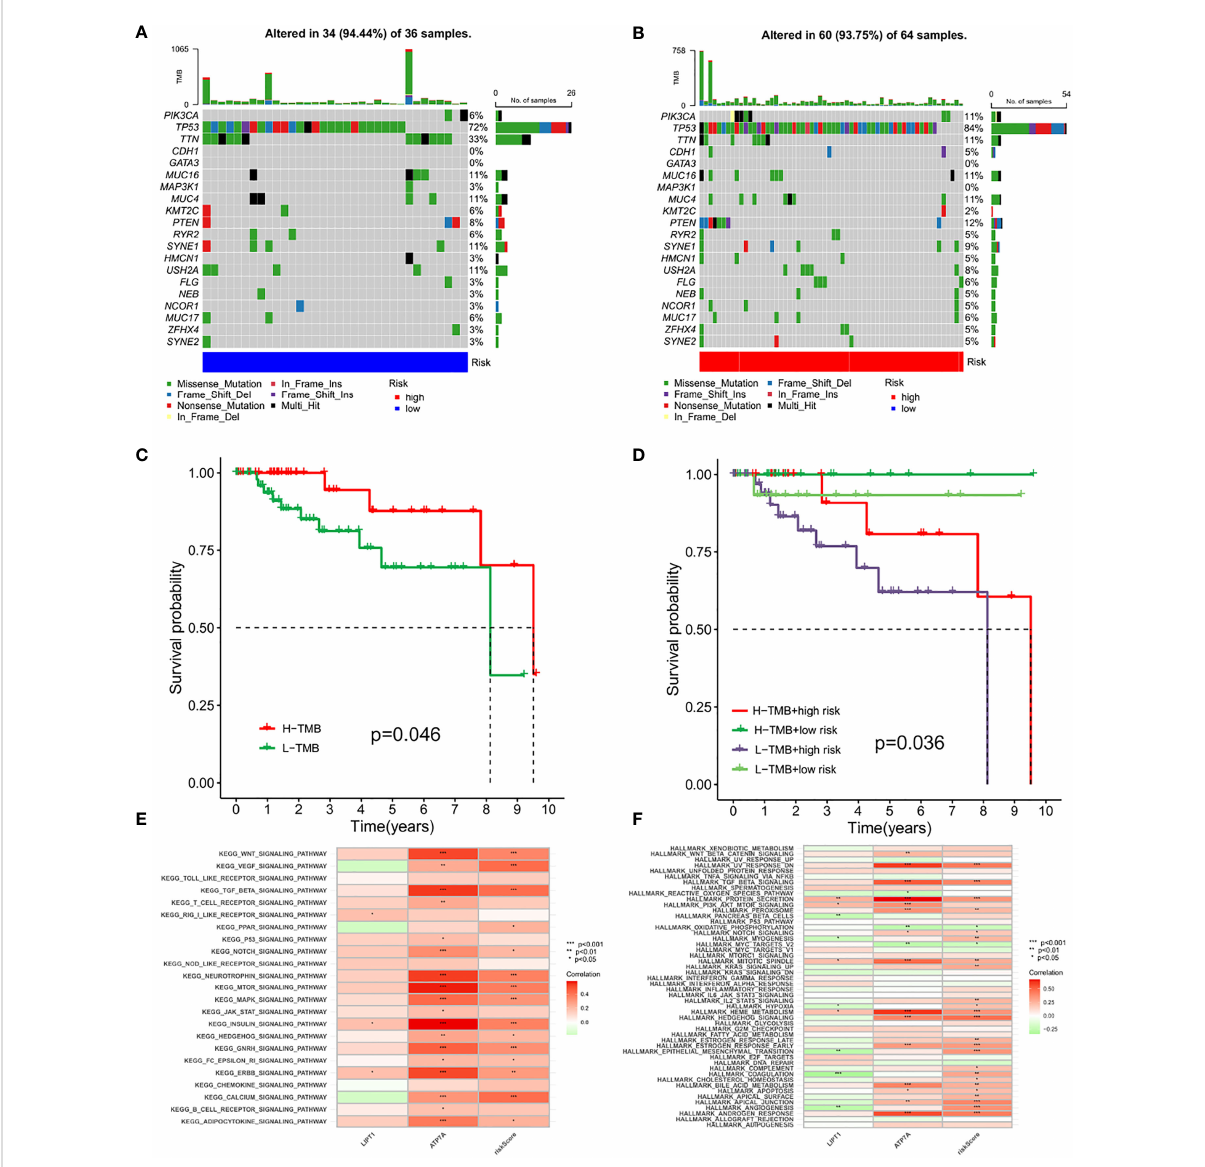
FIGURE 9 Genetic characteristics of CRG_score and tumor somatic mutation of TNBC (A, B) The waterfall plot of tumor somatic mutation established by those with high-and low-risk group. (C) The overall survival of H-TMB and L-TMB using Kaplan – Meier in Log-rank test. (D) The overall survival of the patients strati fi ed by both the CRG-score signature and TMB using Kaplan – Meier curves. (E, F) Correlations between CRGs and Pathway Through KEGG and HALLMARK Enrichment Analysis. The asterisks represented the statistical p value (*P < 0.05; **P < 0.01; ***P <